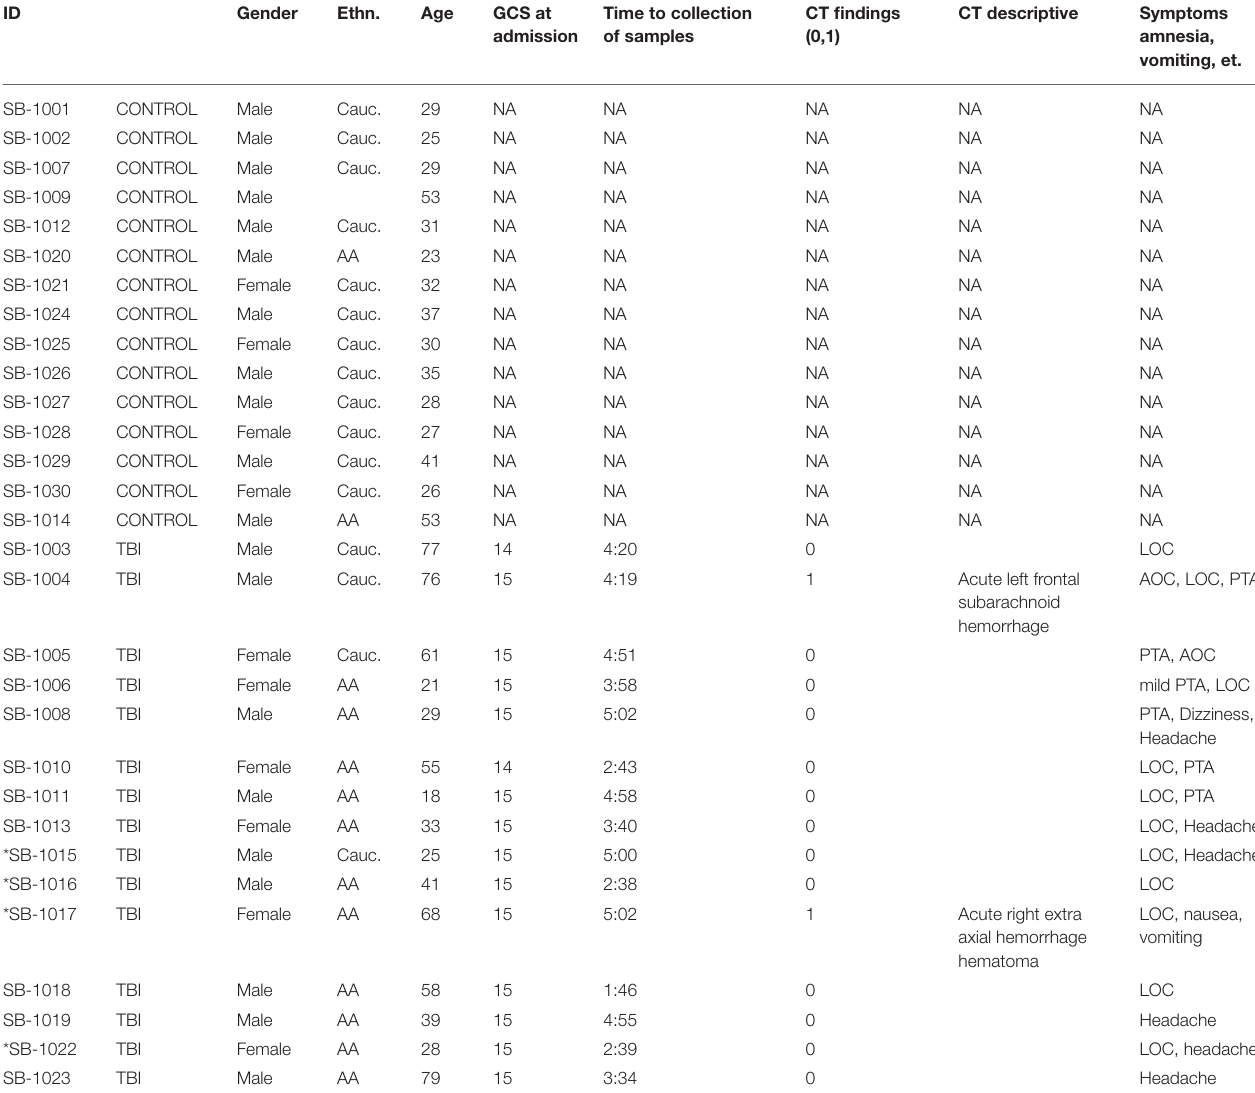
TABLE 1 | Demographic and clinical characteristics of the patients and controls. ID Gender Ethn. Age GCS at